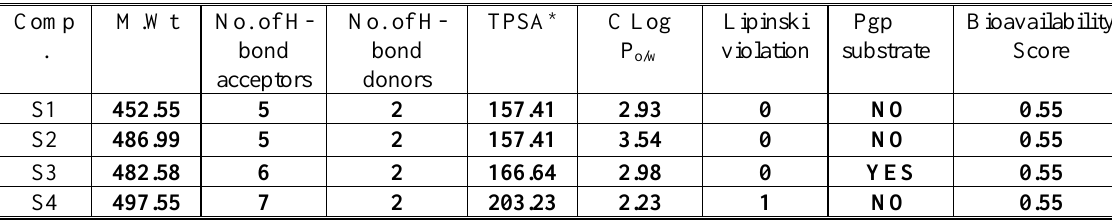
Table 4 . Drug likeness and lipinski rule descriptors of the target compounds . Comp